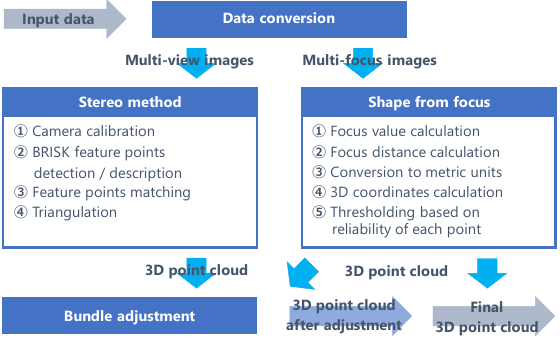
Figure 5. Framework of the proposed